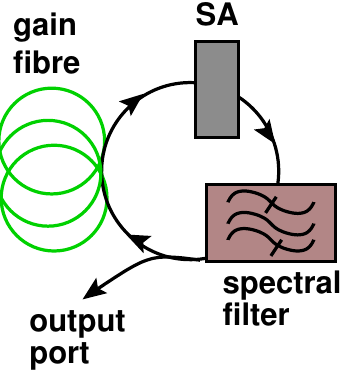
Figure 1. Schematic of the laser. SA: saturable absorber.